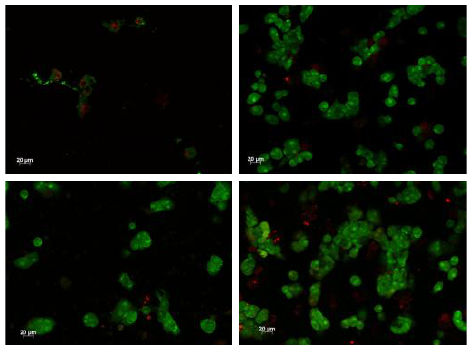
FIGURE 2: Primary Hepatocytes cultured on A) PEG-diamine B) PEG- diacid C) RGDS-PEG D) Galactosamine-PEG. Live/Dead staining carried out after 24 hours (CFDA and Propidium